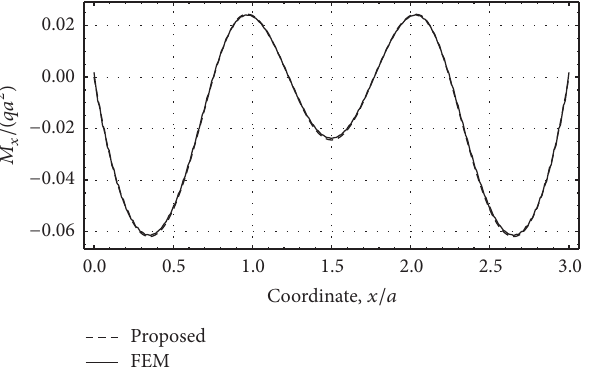
Figure 11: Bending moment 𝑀 𝑥 at 𝑦 = 1.5𝑎 .